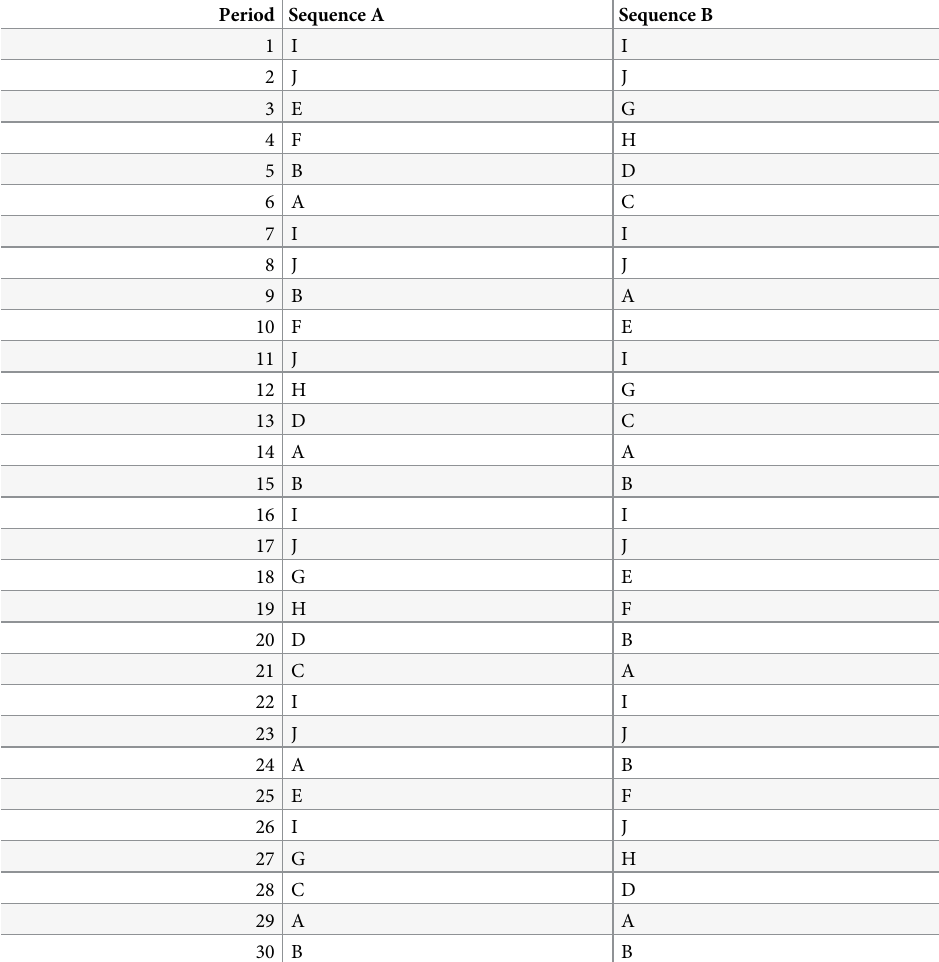
Table 1. Sequence of presentation of price series.